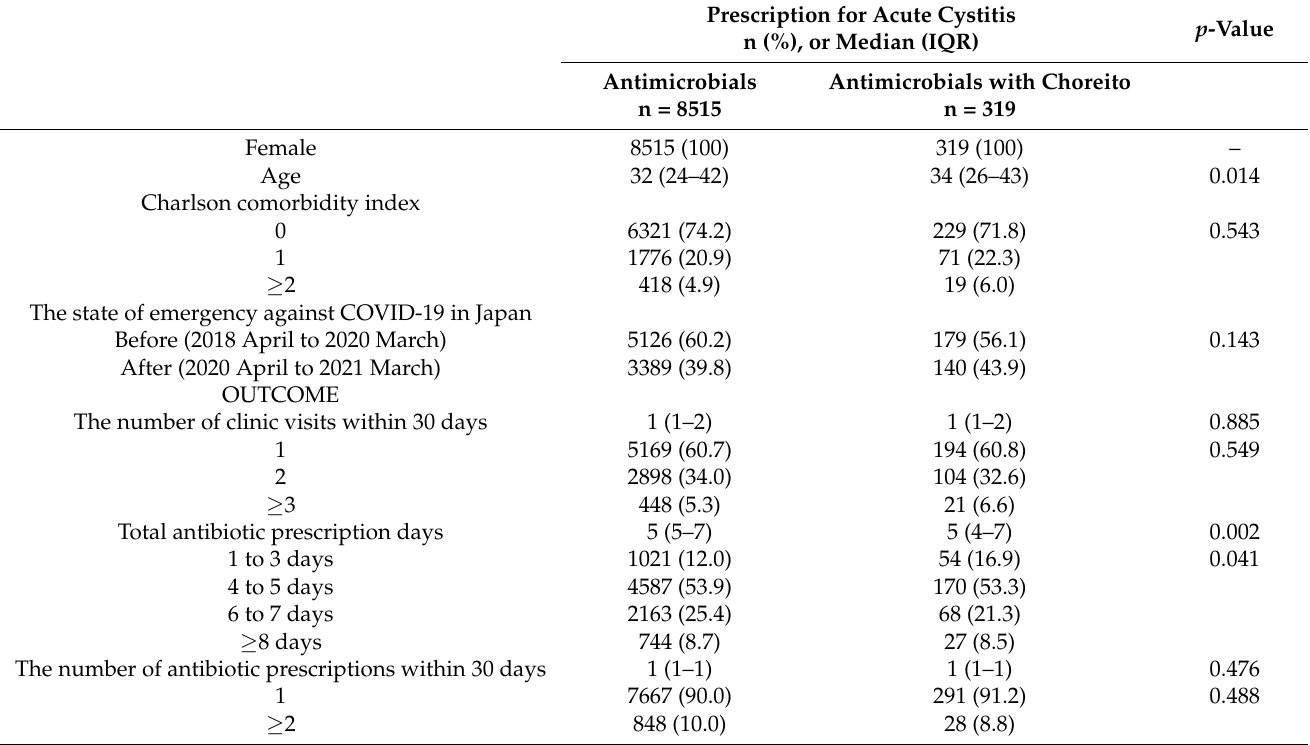
Table 1. Characteristics and outcomes of 8834 females with acute cystitis receiving antimicrobials with or without Choreito (Kampo medicine) at their first clinic visit between April 2018 and March 2021.